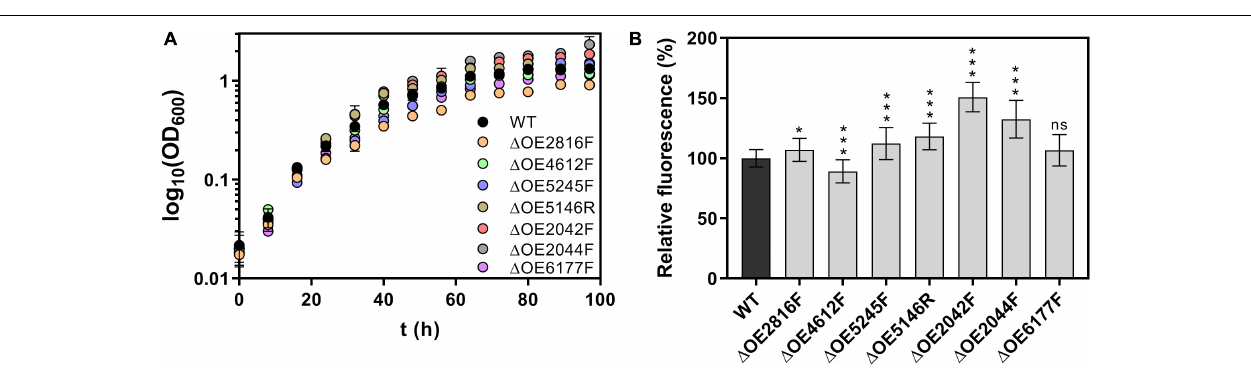
FIGURE 6 | Characterization of H. salinarum R1 wild type (WT) and gene deletion strains. (A) Growth curves of H. salinarum strains with a start optical density (OD 600 ) of 0.02 cultivated over periods of 97 h in complex medium. (B) Fluorescence-based adhesion assays of H. salinarum strain after 15 days of cultivation in complex medium. The diagram shows the relative fluorescence based on adherent cells of the deletion strains relatively compared to the wild type (set to 100%). The significance of the adhesion in gene deletion strains compared to the wild type was determined by t -test (ns, not significant, ∗ significant = p < 0.05, ∗∗∗ extremely significant = p <